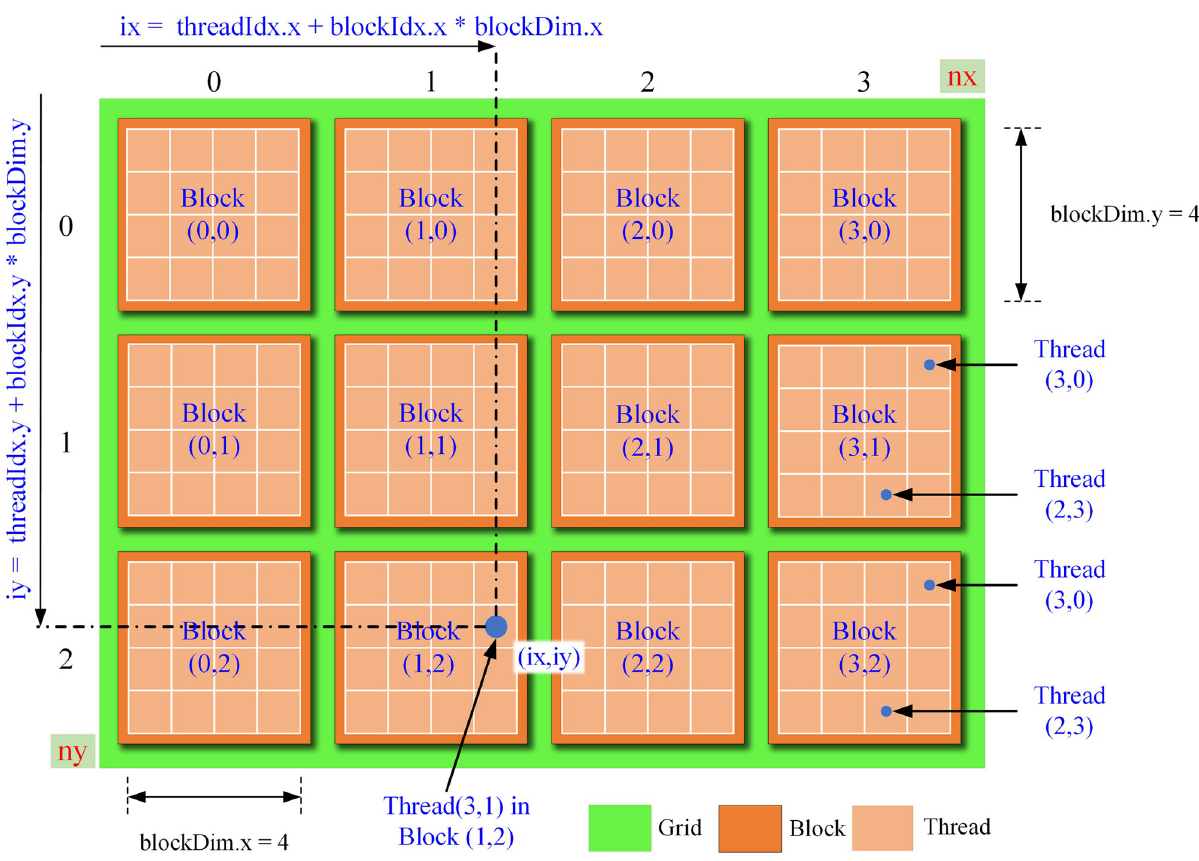
Fig 6. CUDA threading and block organisation of two-dimensional